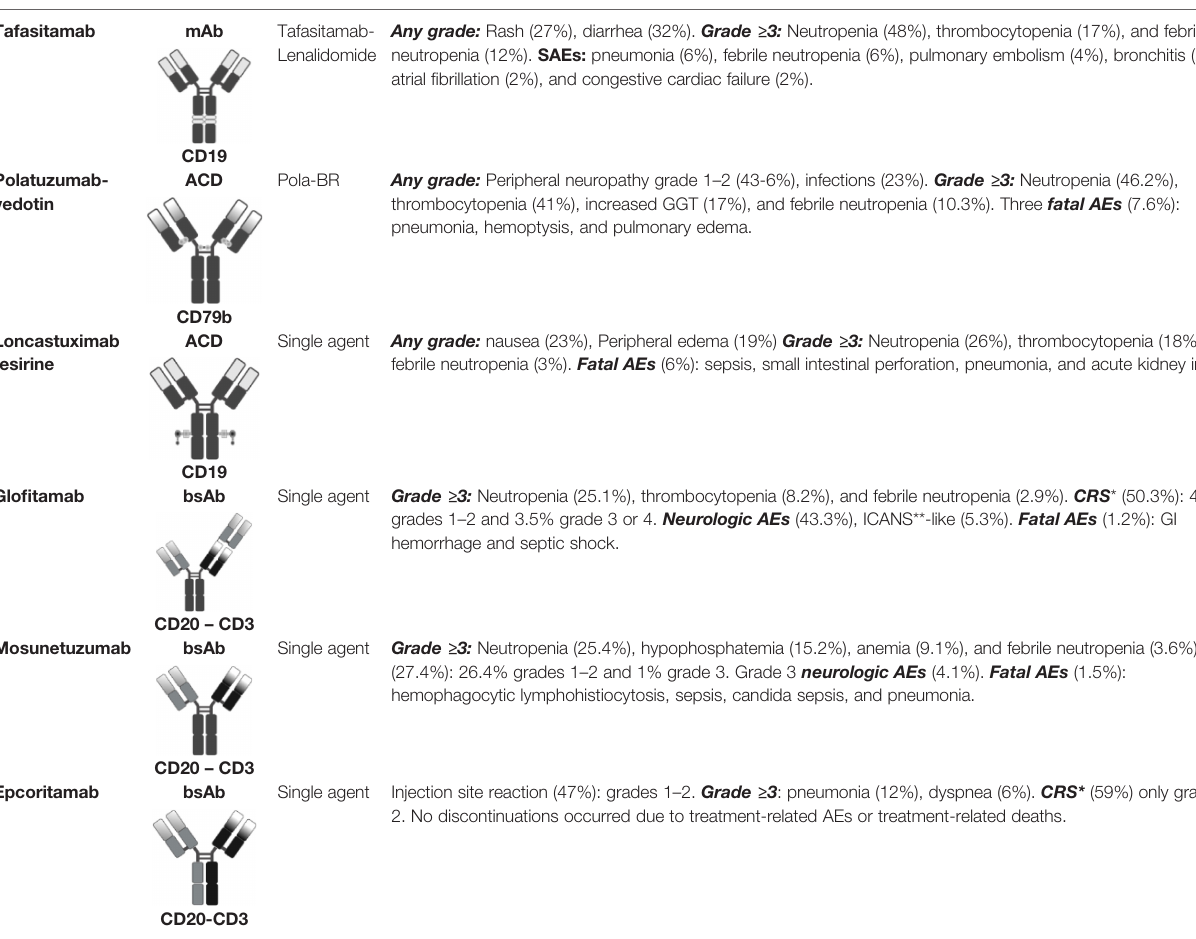
TABLE 2 | Therapeutic Options After CART Failure: Safety Pro fi le.